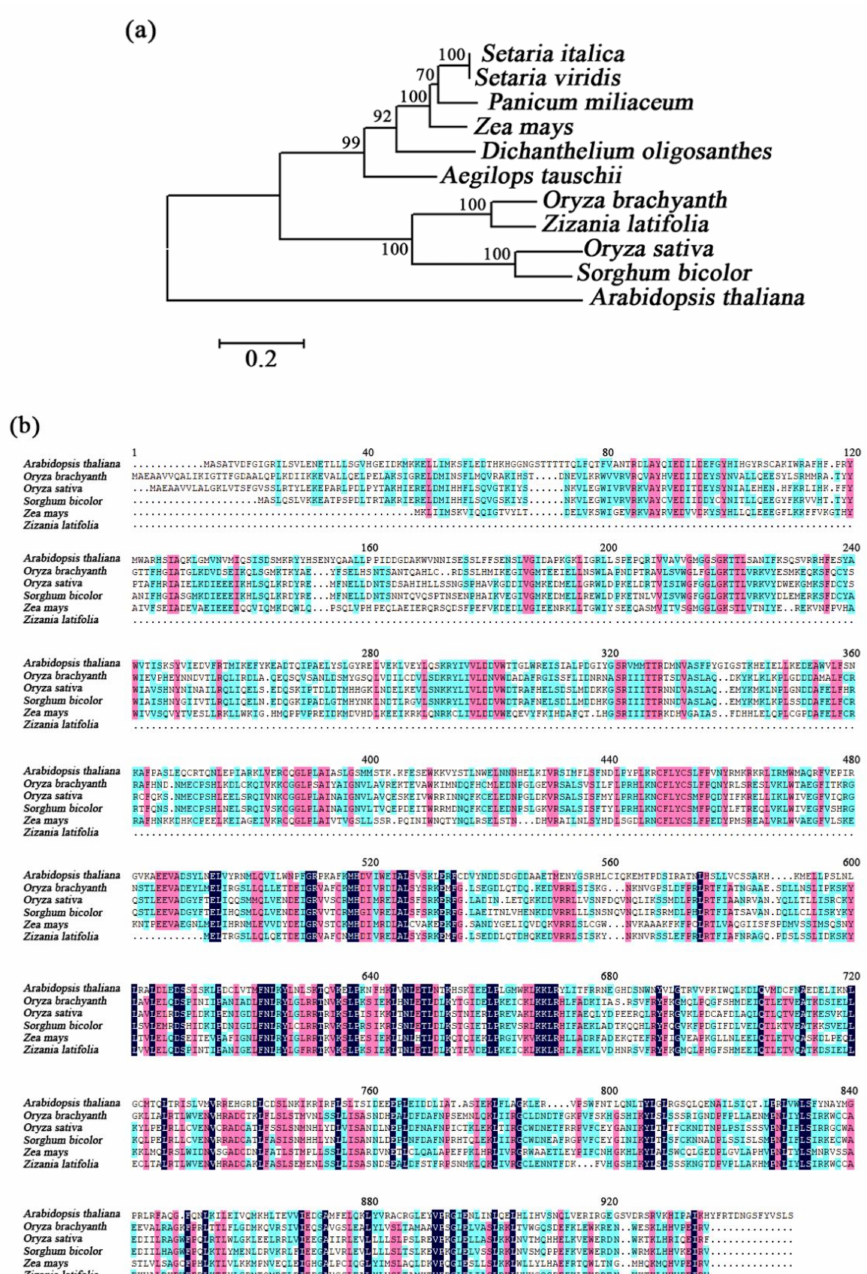
Figure 5. Phylogenetic analysis of ZlRPM1 . ( a ) Phylogenetic tree analysis of ZlRPM1 . ( b ) Amino acid sequence alignment of ZlRPM1